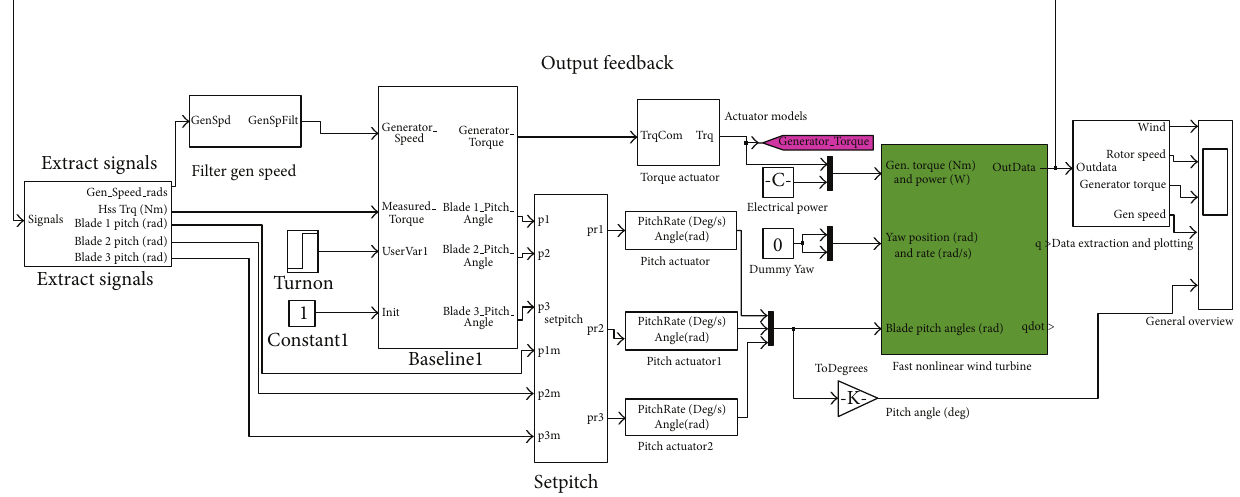
Figure 9: Block diagram of WECS in Matlab.